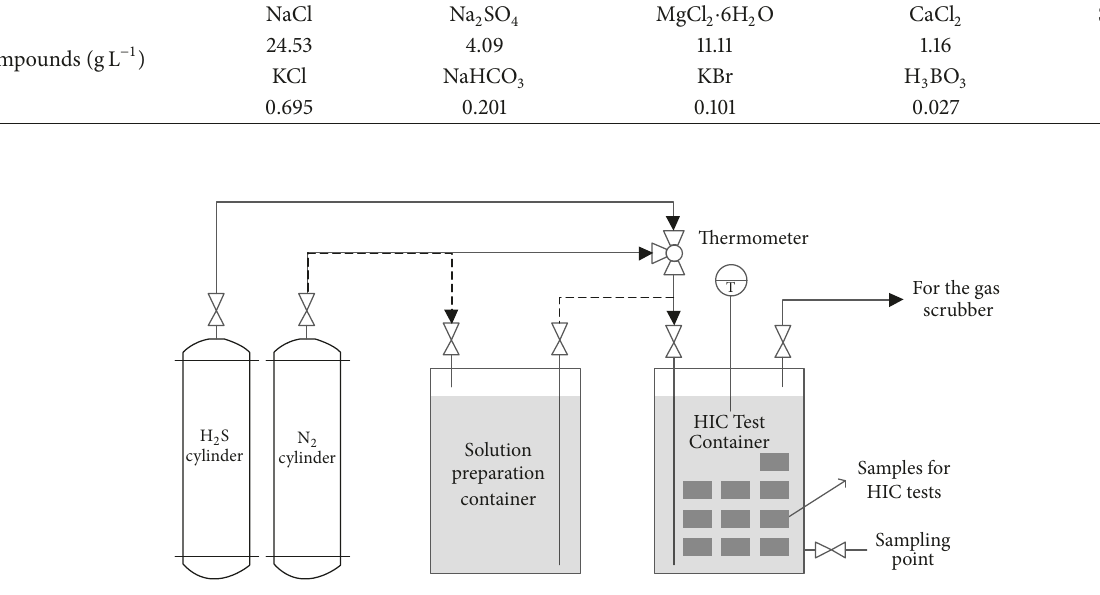
Figure 1: Hydrogen-induced cracking test